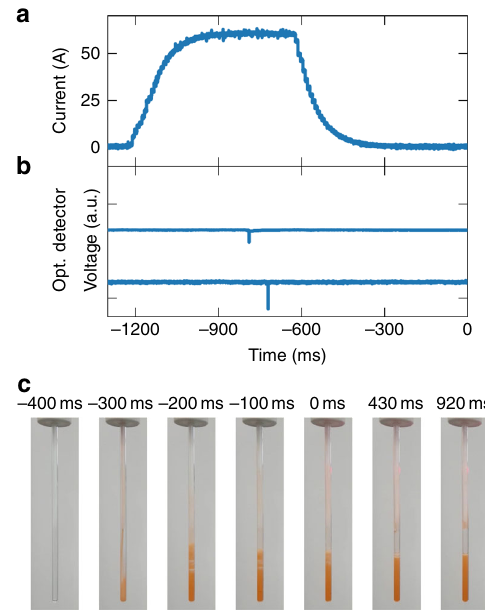
Fig. 2 Timing of the sample ejection, relative to the start of the NMR data acquisition at t = 0. At t = − 1200 ms the coil along the transfer path is energized. The voltage across the coil is ramped up to 200 V in ~150 ms. The current (panel a ) takes ~200 ms to reach its maximum, and subsequently decreases slightly as the coils resistance increases due to resistive heating. At t = − 900 ms the sample ejection routine is executed. The actuator chain comprises a mechanical relay, a pilot valve and an actuated plug valve, leading to a delay of another 100 ms before the bullet passes the fi rst optical detector (panel b , top curve) near its start position, at t = − 800 ms. ~70 ms later the bullet passes the second optical detector inside the second magnet (panel b , bottom curve), where the sample is dissolved in pre-heated solvent. At t = − 500 ms the pinch valve in the injector is opened, and the sample is sucked into an evacuated NMR tube. To demonstrate the loading of the NMR tube, a bullet containing 60 μ L of a 1:1 mixture of red dye and pyruvic acid was shot from the polarizer into the injection device that was preloaded with 700 μ L of degassed H 2 O, heated to 50 °C. Selected frames from a video taken as the solution fl ows into the NMR tube are shown in panel c . The time origin is the same as in panels a , b . The NMR acquisition is triggered at t = 0 aqueous solution is shown in Fig. 2c. The fi lling of the tube is essentially complete at t = 0 ms, ~860 ms after the bullet passes the optical barrier at the tunnel entrance inside the polarizer, and NMR acquisition is triggered. Remaining bubbles at the top of the sample collapse within the fi rst second after the trigger. After the experiment, the injection device is removed from the magnet, the empty bullet is removed manually and the NMR tube is exchanged for a new one.